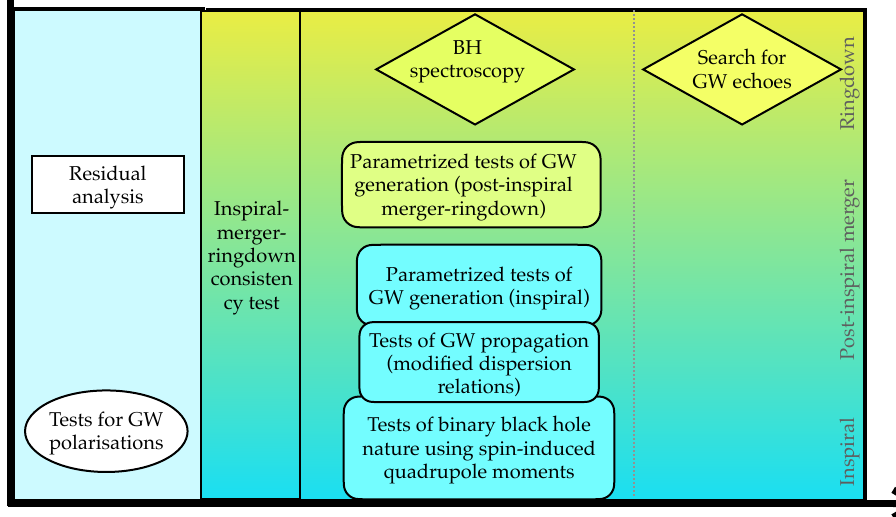
Figure 1. Outline of various tests of GR we discuss in this article. The x-axis denotes the increasing order of GR model assumptions that go into each analysis. The light-blue region on the left side contains the set of tests that require the least assumptions about the signal model. The gradient on the right part of the plot classifies the tests into inspiral, merger-ringdown regimes of the signal from bottom to top. Different shapes indicate different classes of tests: rectangle, rounded rectangle, ellipse, and diamond shapes correspond to consistency tests, parametrized tests, polarization tests, and tests for the merger remnant,